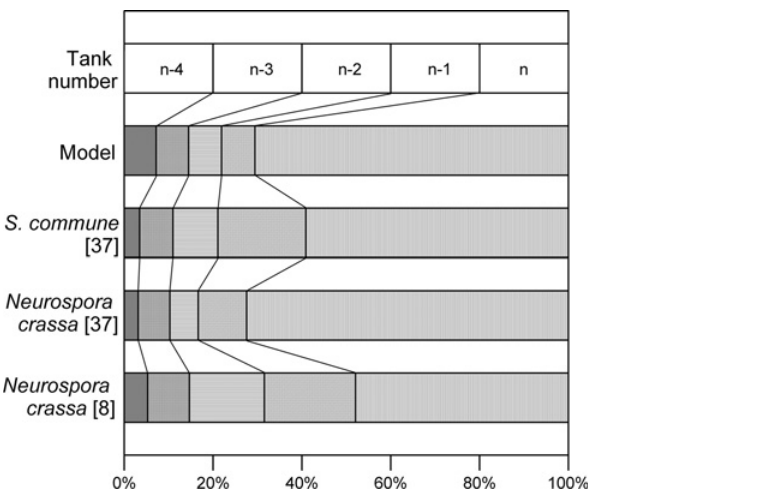
Fig 5. Comparison of the model predictions about vesicle distribution near the tip with experimental data. Model predictions are for 24 h of cultivation, from the simulation done for Rhizopus oligosporus . Experimental studies of Collinge and Trinci [8] and Gooday [37] were used for comparison. The experimental data are plotted based on segments of 10 μ m length, in order to enable a comparison with the last five tanks of the